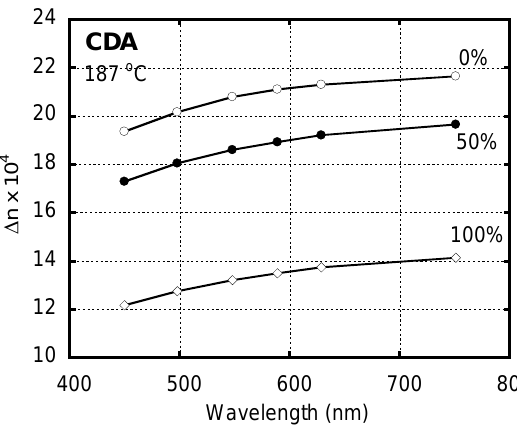
Figure 3. Wavelength dependence of orientation birefringence Δ n for CDA stretched at a draw ratio of 1.5 and exposed to 0% humidity (open circles), 50% humidity (closed circles) and 100% humidity (open diamonds). Drawing temperature is 187